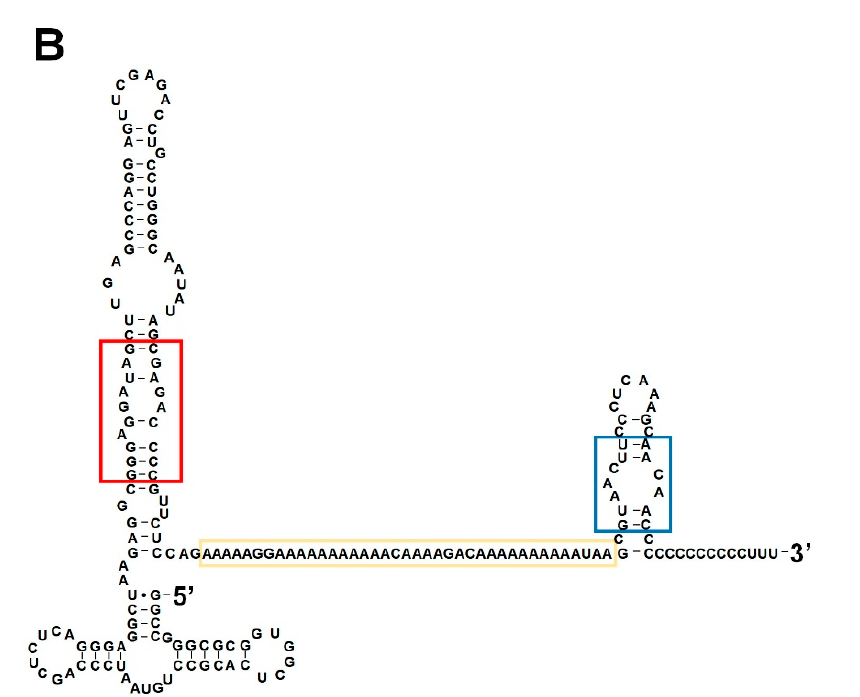
Figure 2. Secondary structures of BC1 RNA and BC200 RNA. ( A , B ) BC1 RNA and BC200 RNA are functional analogues. Secondary structures of BC1 RNA ( A ) and BC200 RNA ( B ) with common functional motifs (the GA kink motif in the red box, the poly A region in the yellow box, and the C-loop motif in the blue box).